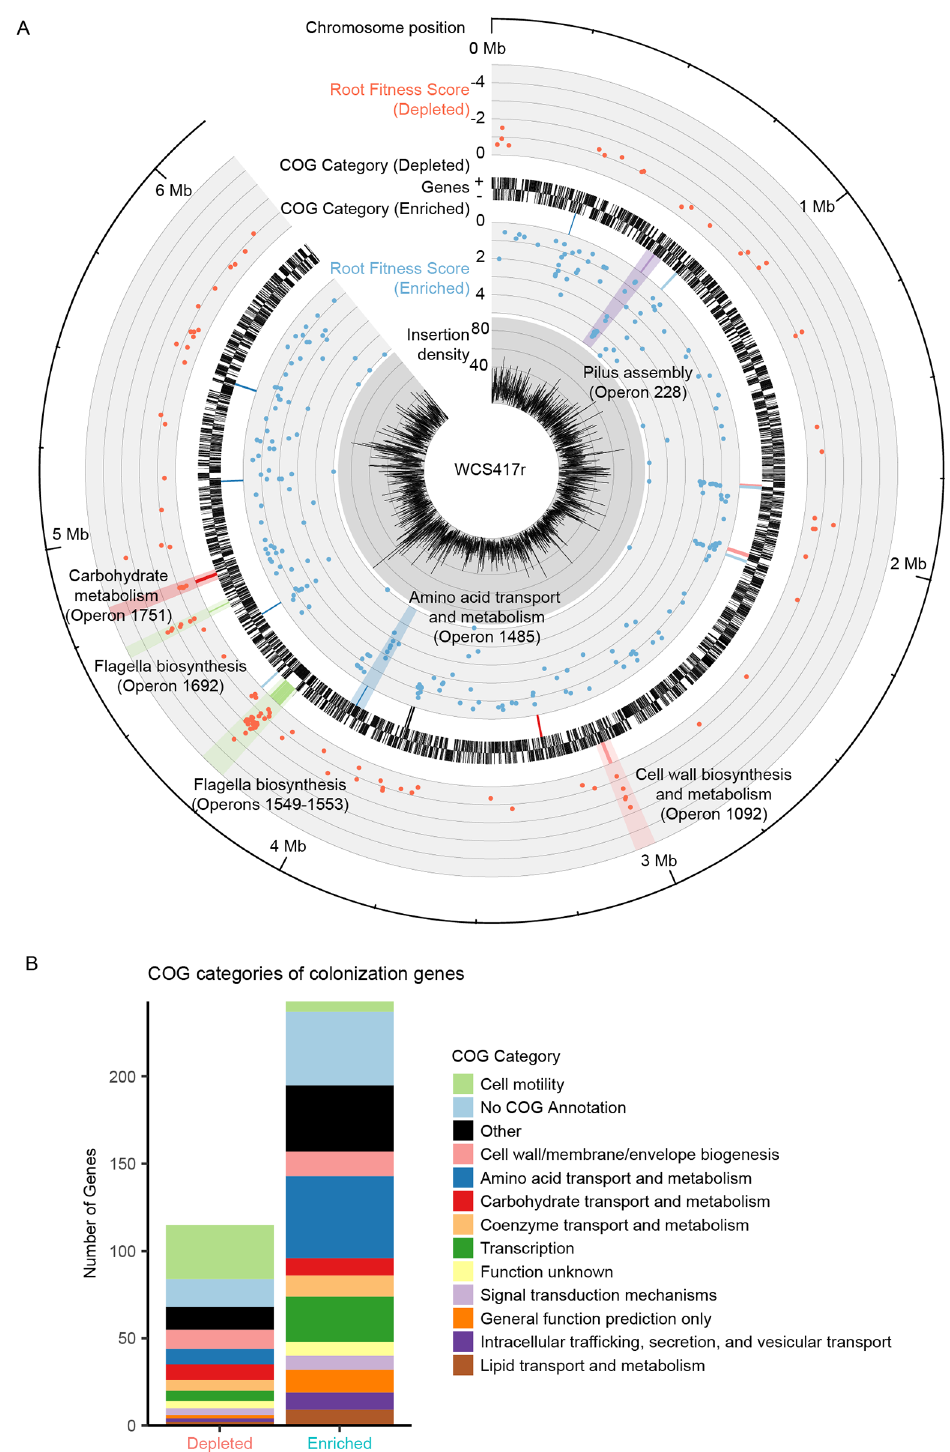
Fig 2. Genome-wide map of root colonization. (A) Inner to outer tracks: transposon insertiondensity (per 1 kb); fitness score for geneswith enhanced colonization ability when mutated; dominant cluster of orthologous group (COG) category for operonswith 3 or more colonization-enrichedgenes(Table 1), gene density (for each strand); dominant COG category for operonswith 3 or more colonization-reducedgenes(Table 1); fitness score for genes with reducedcolonization ability when mutated; chromosomal position.(B) Color legendof dominant COG categories and highlights are shown. (B) Distributionof genes significantly depleted or enrichedamongCOG categories (see S1